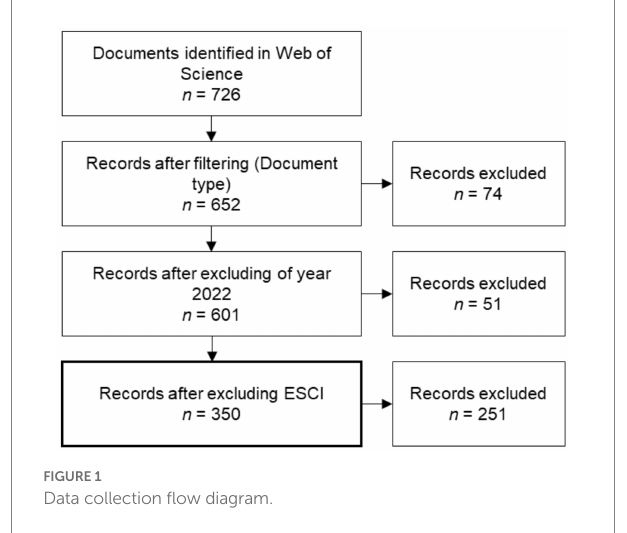
FIGURE 1 Data collection flow diagram.